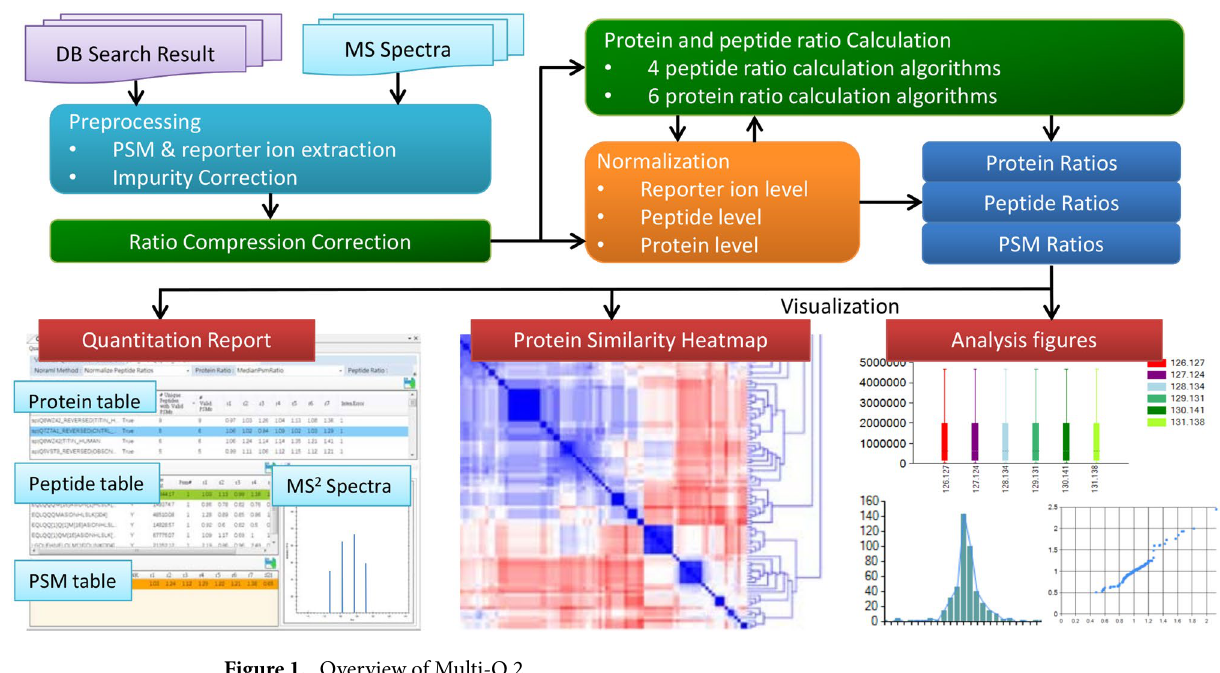
Figure 1. Overview of Multi-Q